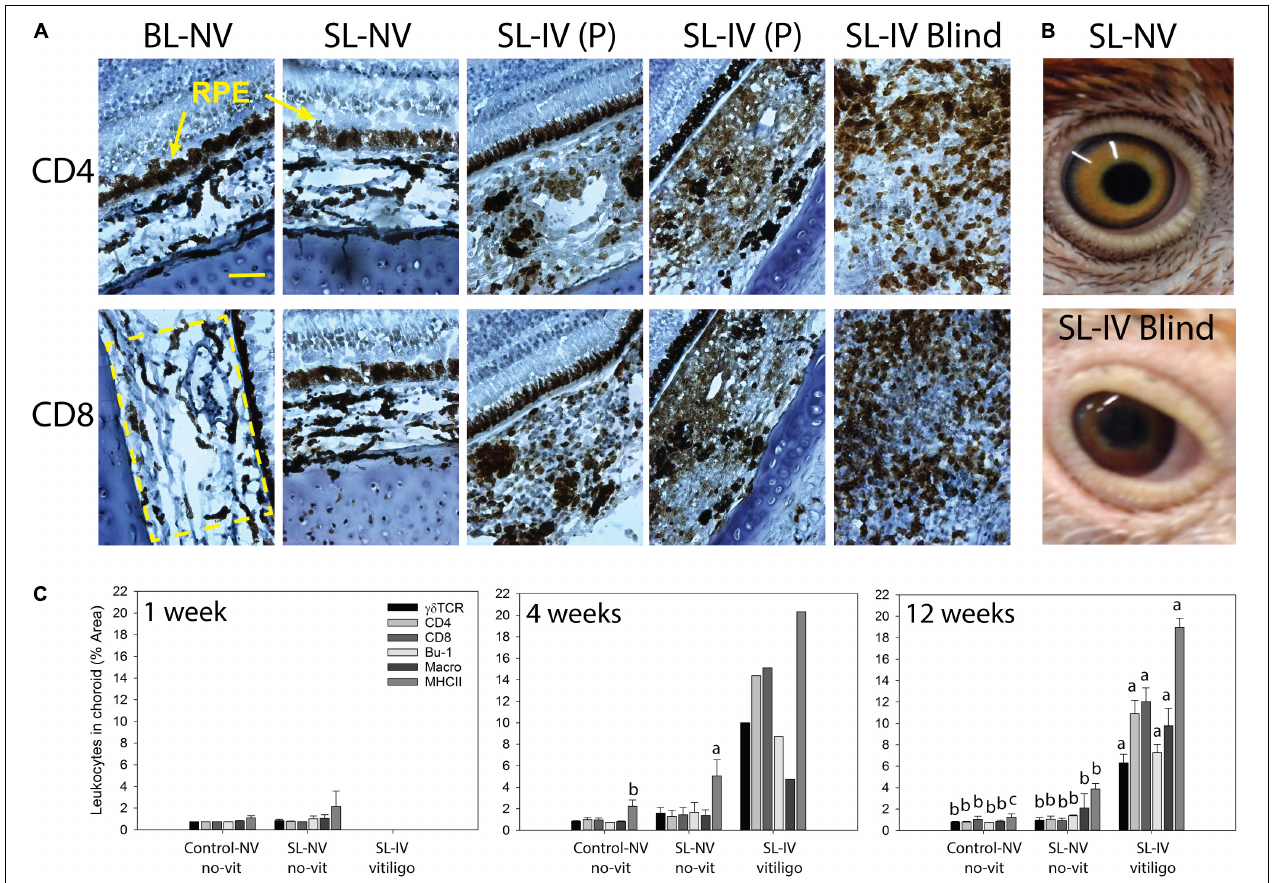
FIGURE 1 | Mononuclear leukocyte presence and MHC class II expression in choroids of healthy controls and Smyth line (SL) chickens with and without vitiligo and visual impairment. (A) Representative CD4 or CD8 IHC-stained cells in frozen sections (7 µ m) of eyes from 12-week-old chickens. BL-NV: Normally sighted (NV) parental Brown line (BL) control without vitiligo (no-vit); SL-NV: normally sighted, vitiligo-prone Smyth line (SL) chicken without vitiligo; SL-IV: vision-impaired SL chickens [partially sighted (P) or blind], all SL-IV chickens had vitiligo. RPE (retinal pigmented epithelium) is destroyed in blind SL-IV chickens. (B) The appearance of eyes in an SL-NV chicken without vitiligo (top) and a vitiliginous, blind SL-IV chicken (bottom). (C) Presence (% area) of T cell subsets ( γδ , CD4, and CD8), B cells, macrophages, and MHC class II+ cells in choroids of controls, SL-NV, and SL-IV (includes P and blind). At each age, mononuclear cells were identified by indirect immunohistochemistry (IHC) using chicken marker-specific mouse monoclonal antibodies, biotinylated horse-antimouse IgG secondary antibody, and Vekta-stain Elite ABC reagents (streptavidin and biotin-conjugated peroxidase). Size-bar = 100 µ m. Data are mean ± SEM; per age group, n = 6 and 3 for control and SL-NV, respectively; SL-IV: n = 0 at 1 week, n = 1 at 4 weeks, and n = 10 at 12 weeks. (A–C) Within an age group and across sample categories (control-NV, SL-NV, and SL-IV), mean levels of individual cell types without a common letter are different ( P ≤